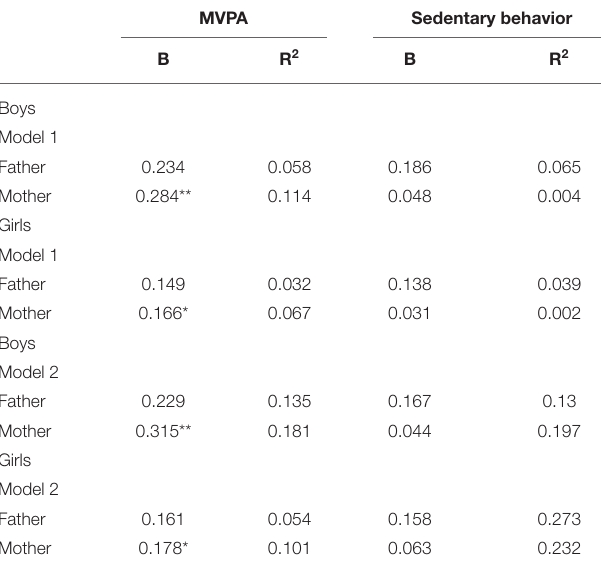
TABLE 3 | Linear regression analysis for variables predicting children’s activity level.